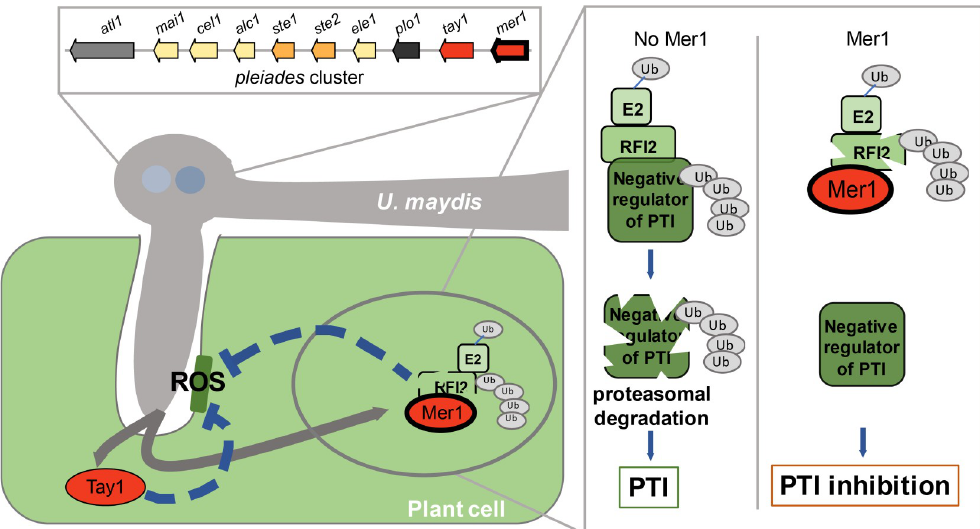
Fig 6. Working model on the mode of action of the Pleiades. Left side: Infection of maize by U . maydis triggers RBOH- mediated production of Reactive Oxygen Species (ROS)in plant cells around invading hyphae. To counteract this early defense response, U . maydis secretes the Pleiades, a heterogeneous group of effectors whose genes are clustered in the genome. Paralogous genes are represented with the same color. Most Pleiades inhibit PAMP-triggered ROS-burst. Tay1 (red oval), inhibits the production of ROS from the cytoplasm. Mer1 (simple red oval with black border), targets the host nucleus, where it promotes auto-ubiquitination and degradation of RFI2s, a family of E3s that regulate the production of. Right side: Hypothetical mode of action of RFI2s. In the absence of Mer1, RFI2s promote the degradation of negative regulators of ROS production. Mer1 leads to the accumulation of the negative regulators and inhibition of ROS production.